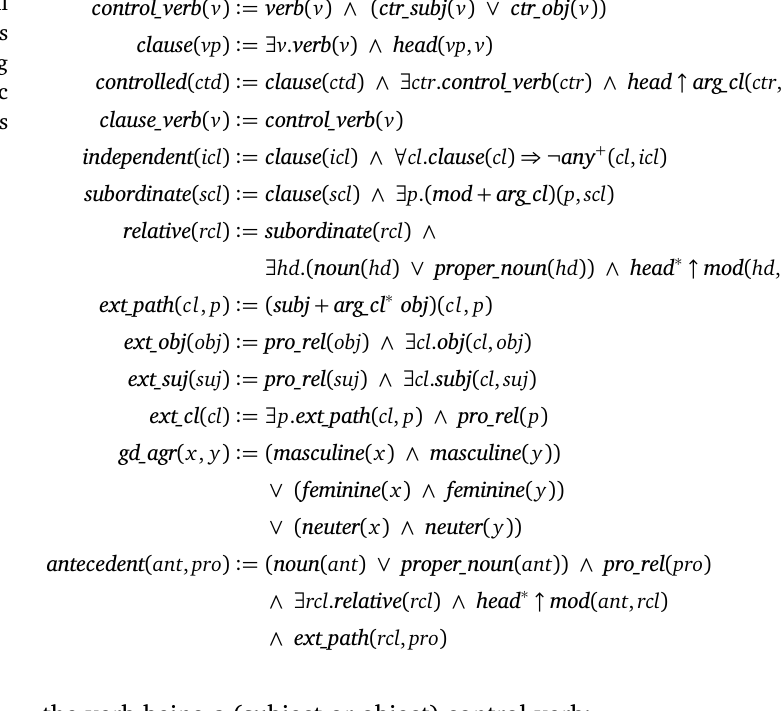
Table 3: Logical predicates